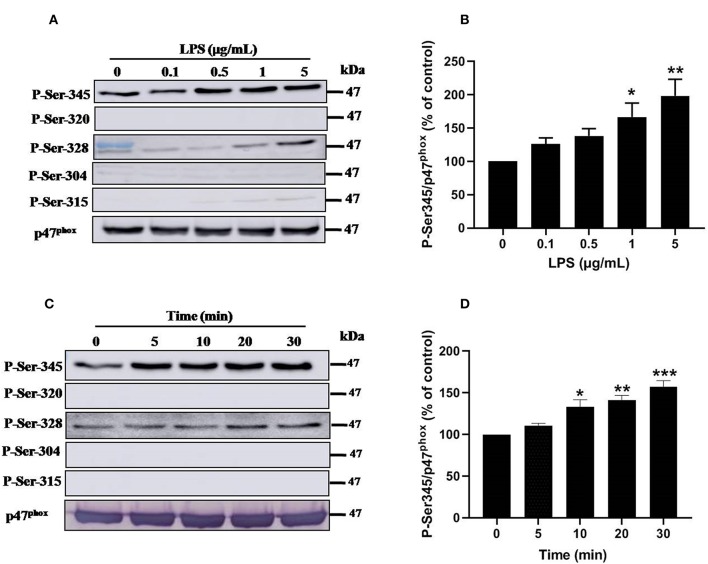
Effect of LPS on p47phox phosphorylation in neutrophils. (A) Neutrophils (10 × 106 cells/mL) were incubated with various concentrations of LPS (0, 0.1, 0.5, 1, 5 μg/mL) for 20 min at 37°C and the cells were lyzed. Proteins were analyzed by SDS-PAGE and western blot using anti-phospho-Ser-345, anti-phospho-Ser-320, anti-phospho-Ser-328, anti-phospho-Ser-304, anti-phospho-Ser-315, and anti-p47phox antibodies. (B) Western blots from different experiments were scanned and quantified. The intensity of bands was expressed relative to total p47phox amount. The cumulated data of phospho-Ser-345 is shown in the histogram as percentage to control (Resting 100%). (C) Neutrophils (10 × 106 cells/mL) were incubated with LPS (1 μg/mL) for indicated times (0, 5, 10, 20, 30 min). Cells were analyzed by SDS-PAGE and immunoblotting with anti-phospho-Ser-345, anti-phospho-Ser-320, anti-phospho-Ser-328, anti-phospho-Ser-304, anti-phospho-Ser-315, and anti-p47phox antibodies. (D) Western blots from different experiments for the kinetic effect were scanned and quantified. The intensity of bands was expressed relative to total p47phox amount. Data are mean ± SEM of three or more separate experiments. *p < 0.05, **p < 0.01 and ***p < 0.001 as compared to control (100%).